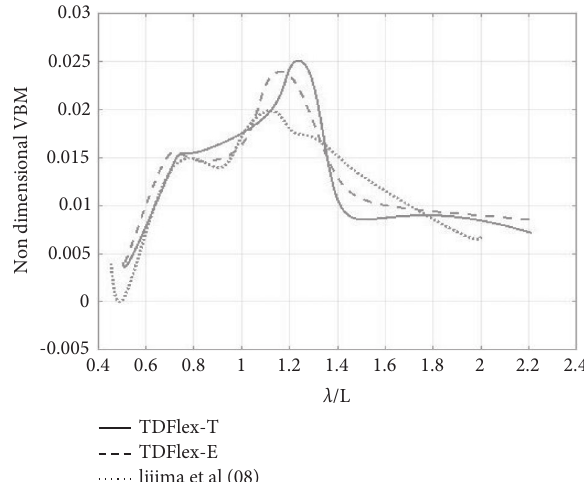
Figure 6: VBM transfer function at midship of S175 ( F